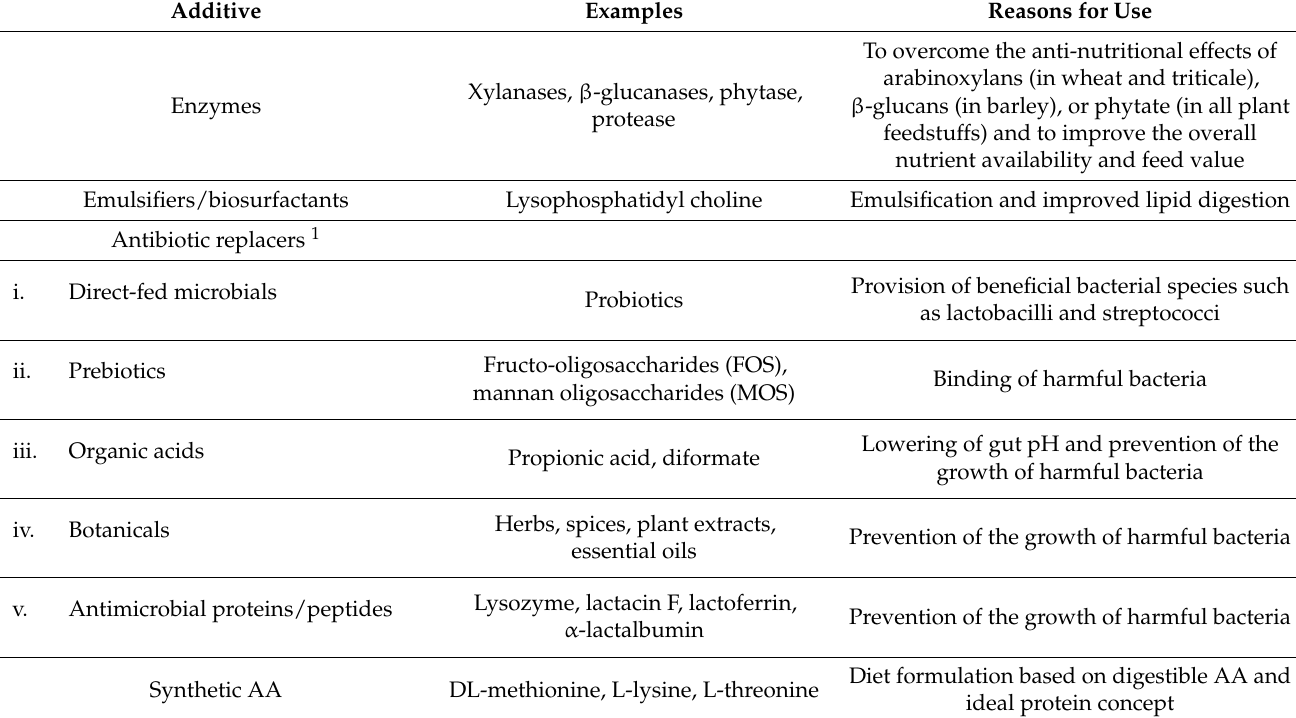
Table 6. List of feed additives useful in young chick